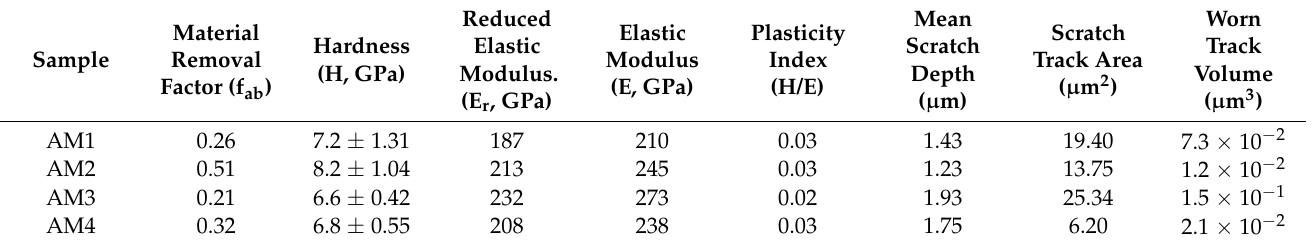
Table 5. Results obtained for Co-Cr-Mo alloy samples AM1, AM2, AM3, and AM4 submitted to the scratch testing